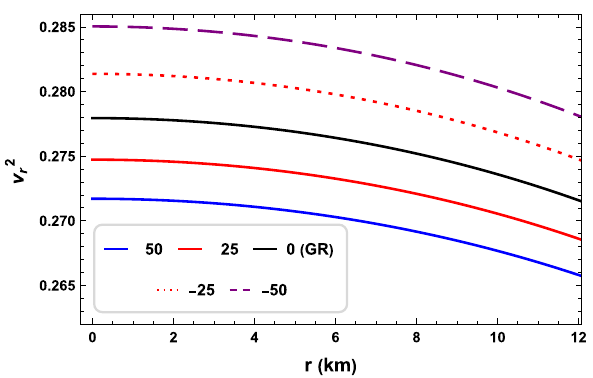
Fig. 8 Radial variation of square of the radial sound velocity ( v 2 r ) for different α in PSR J0348+0432 in